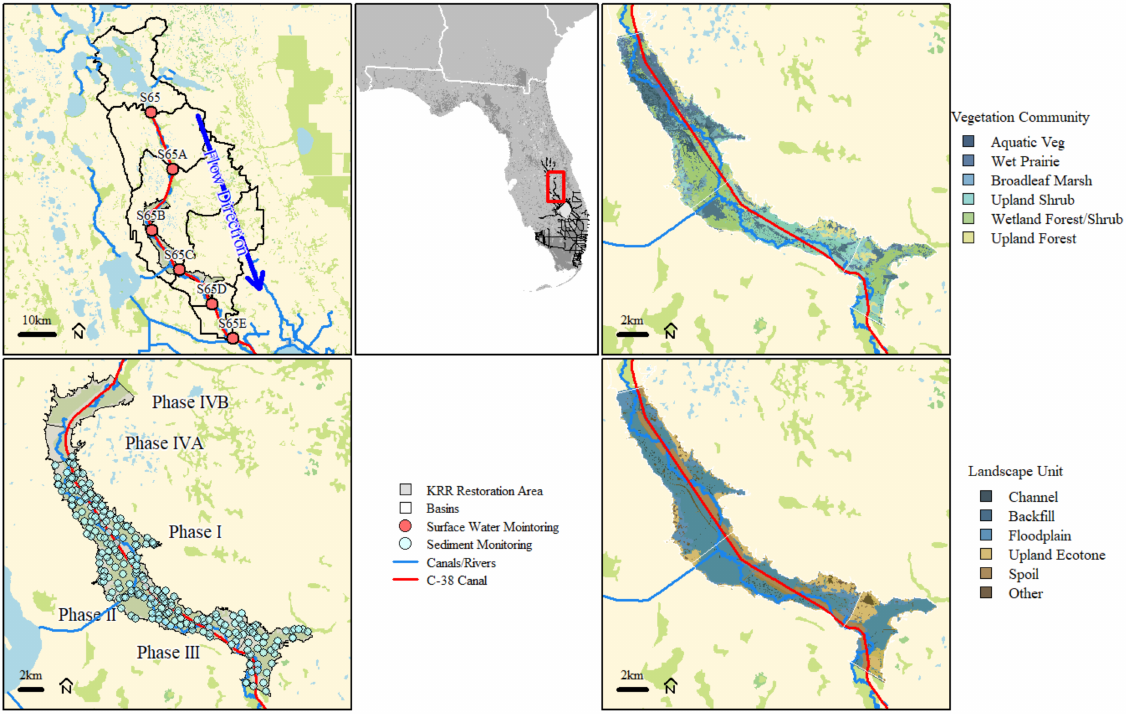
Figure 1. Surface water monitoring locations with the general direction of flow identified ( top left ) for the entire Kissimmee River basin; sediment monitoring locations ( bottom left ), overall study area ( top middle ), specific to the Phase I, II, and III segments of the Kissimmee River floodplain; vegetation ( top right ) and landscape unit ( bottom right ) coverages within the lower segments of the Kissimmee River